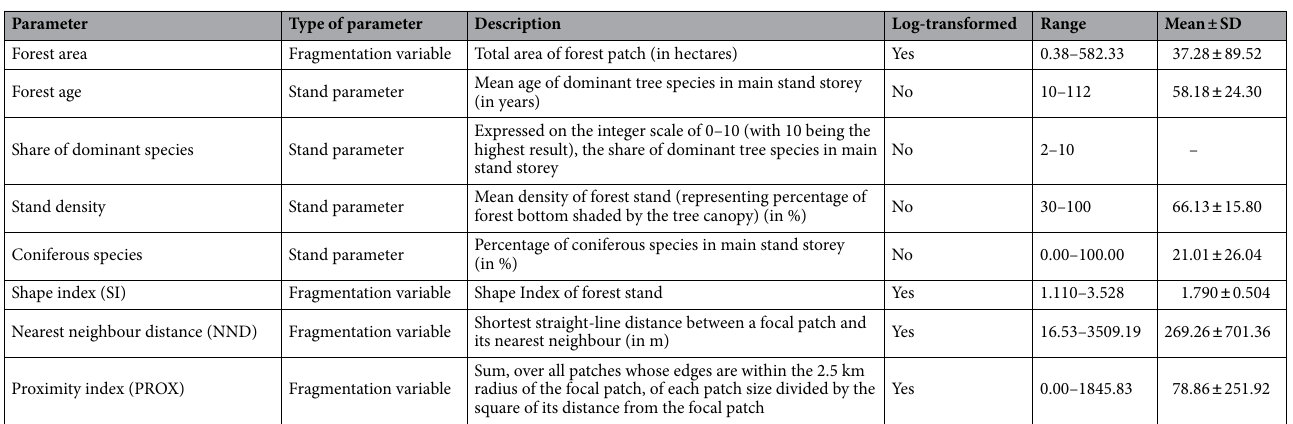
Table 1. Stand parameters and isolation metrics of studied forest